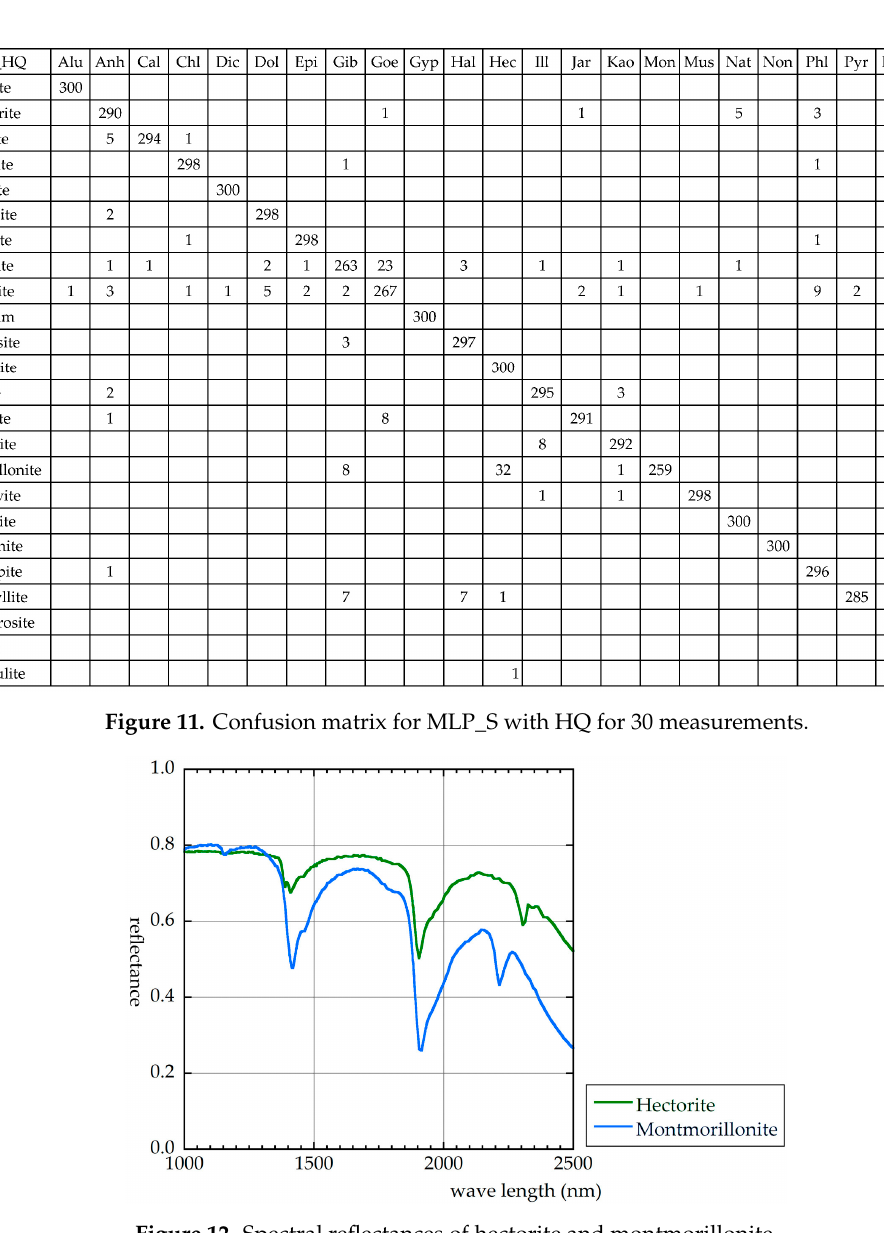
Figure 12. Spectral reflectances of hectorite and montmorillonite.